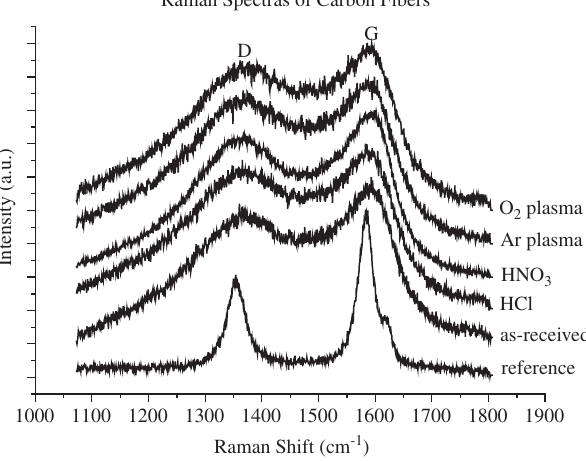
Figure 5. Raman spectra of carbon fibers untreated (as-received), treated with acids, by the plasma process, and heat-treated at 2100 °C (reference).